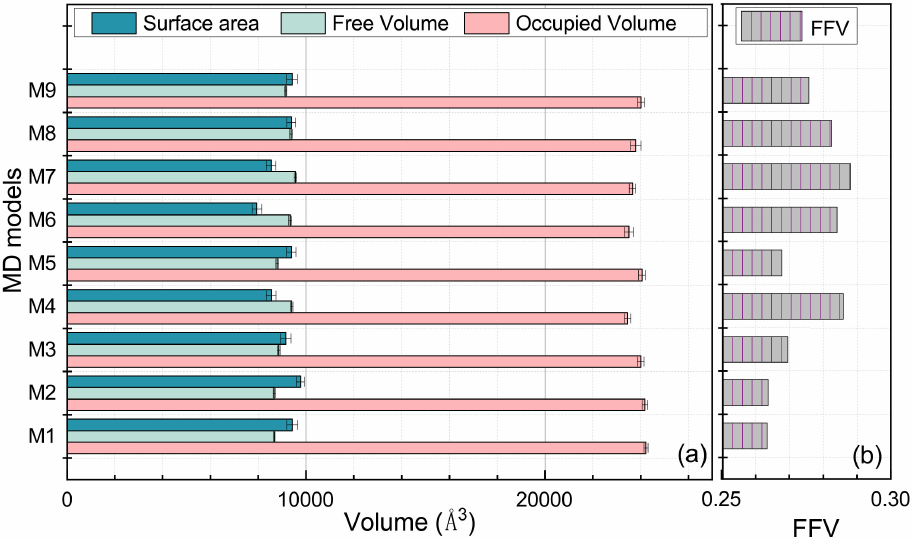
Figure 12. The volumetric parameters of the MD models. ( a ) describes the occupied volume, the free volume and the area of the Connolly surface of varied cross-linked EPDM models, and ( b ) illustrates the FFV of these MD